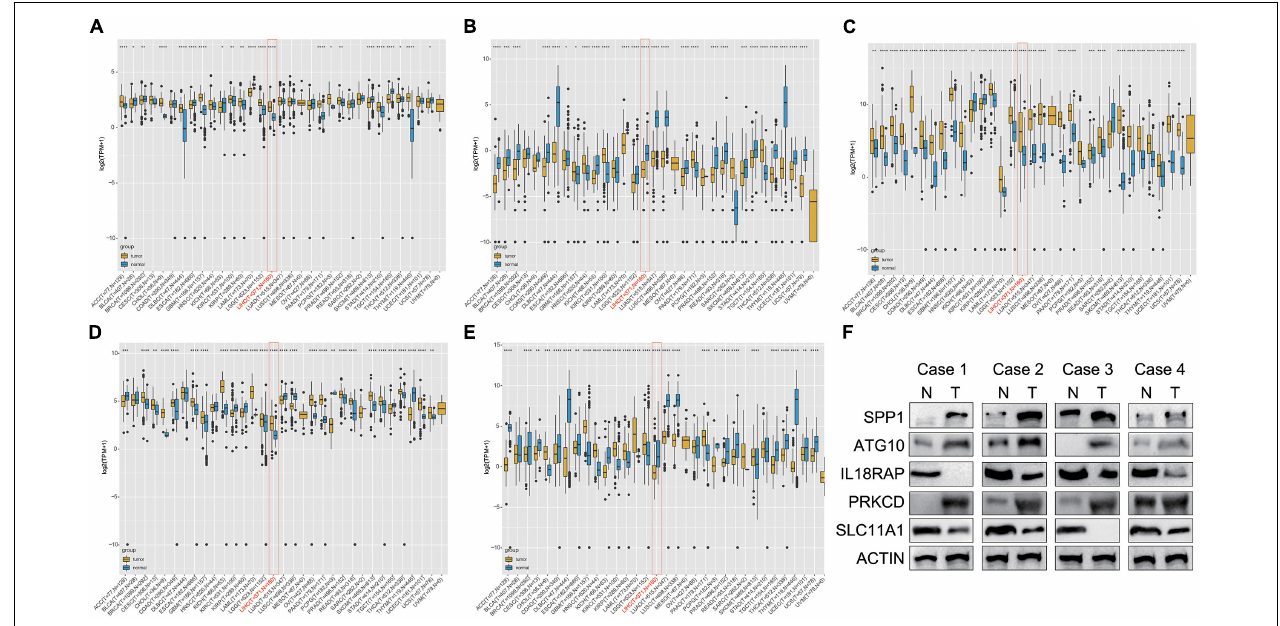
FIGURE 11 | Differential box diagram of 5-gene expression in pan-cancer. (A) ATG10, (B) IL18RAP, (C) SPP1, (D) PRKCD, (E) SLC11A1, and (F) the protein expression of the 5 genes in 4 pairs of LIHC and normal samples. * P < 0.05, ** P < 0.01, *** P < 0.005, and **** P < 0.001.